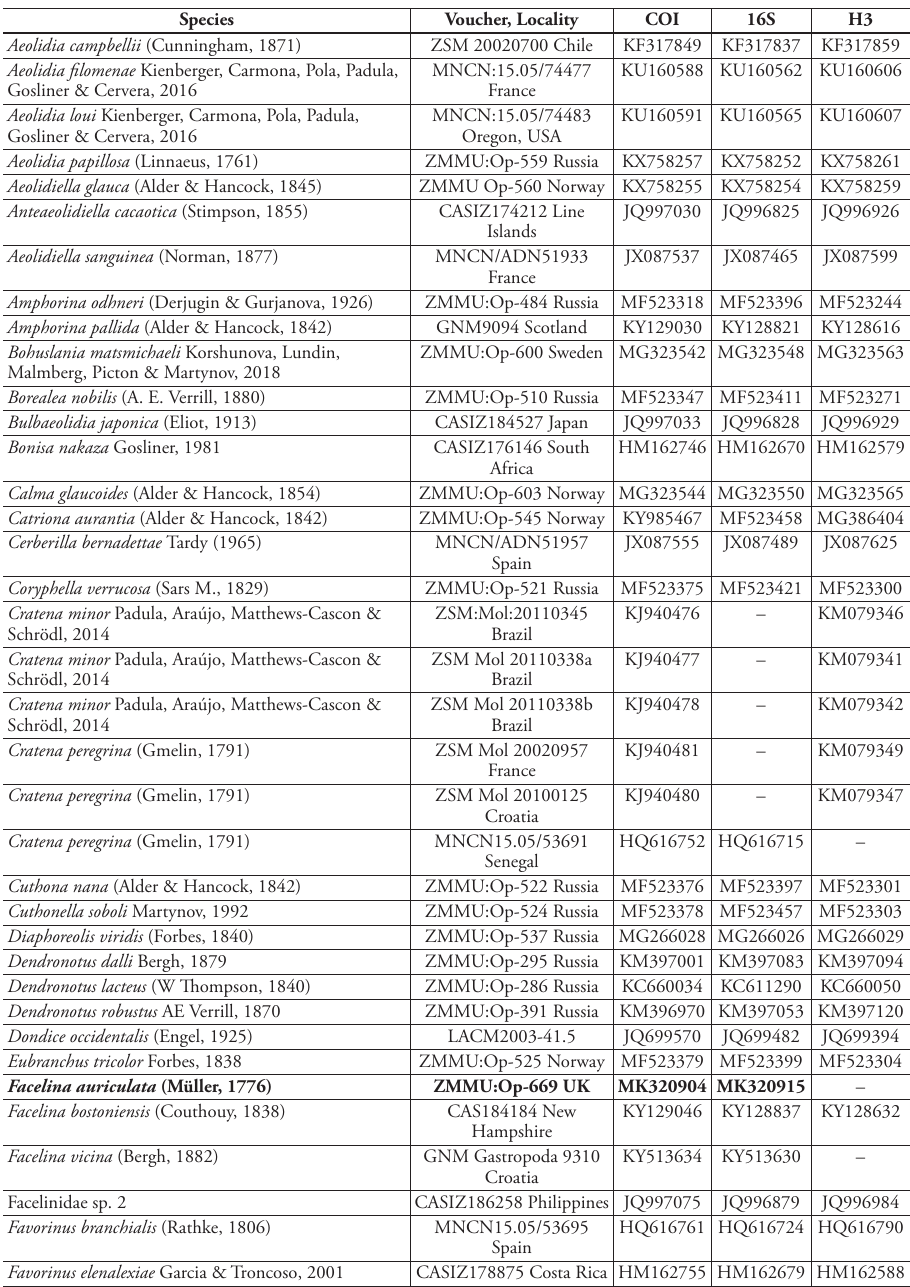
Table 1. List of samples, localities, and voucher references. The species in bold font are those sequenced in this